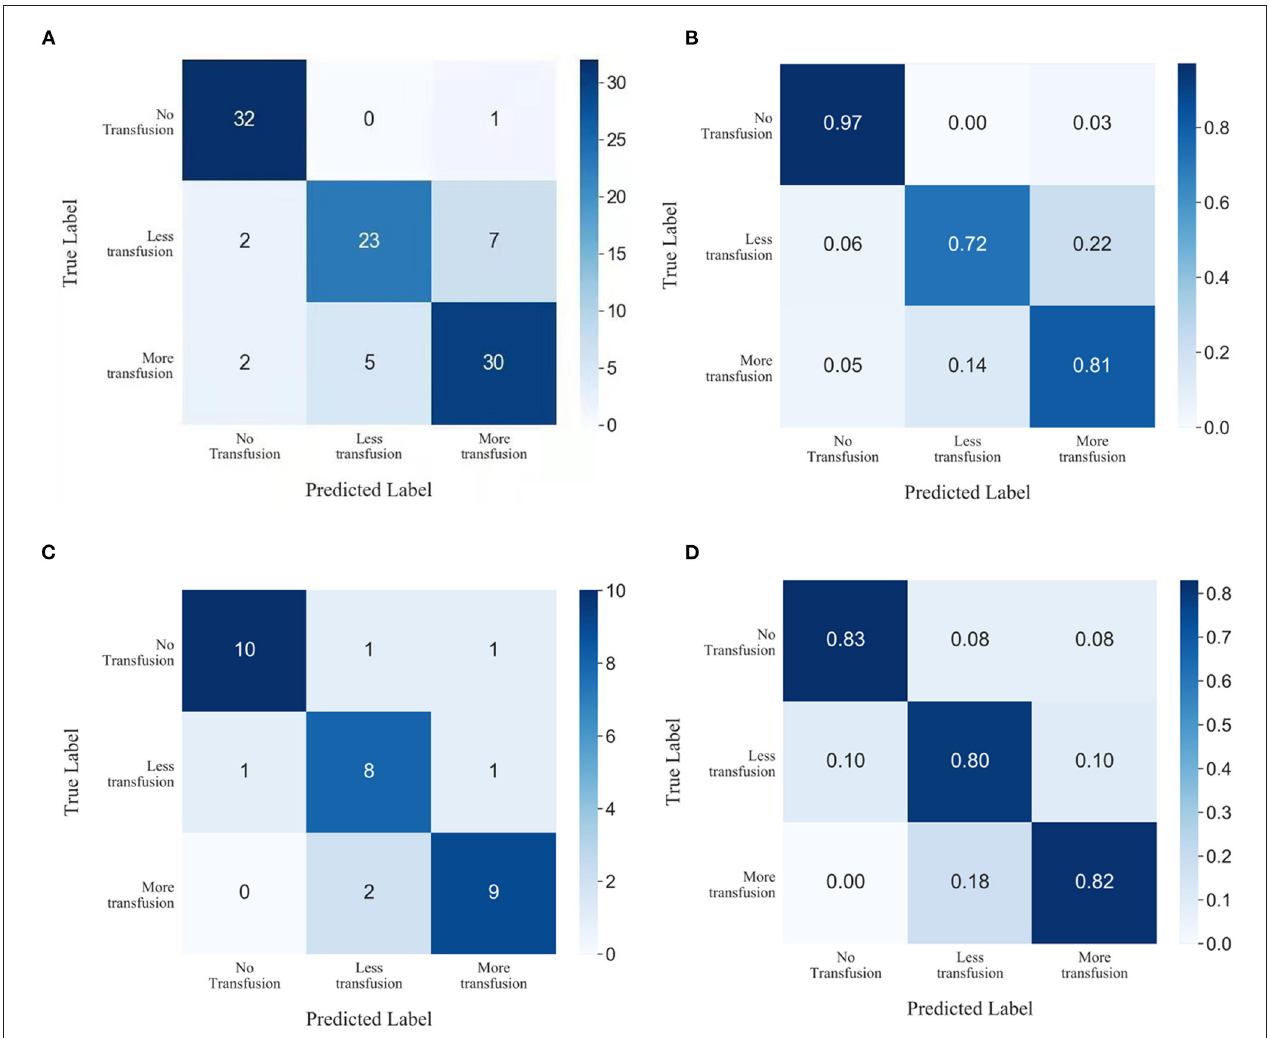
FIGURE 5 | Confusion matrix showing the prediction results of XGBoost machine learning in (A,B) test subset and (C,D) prospective